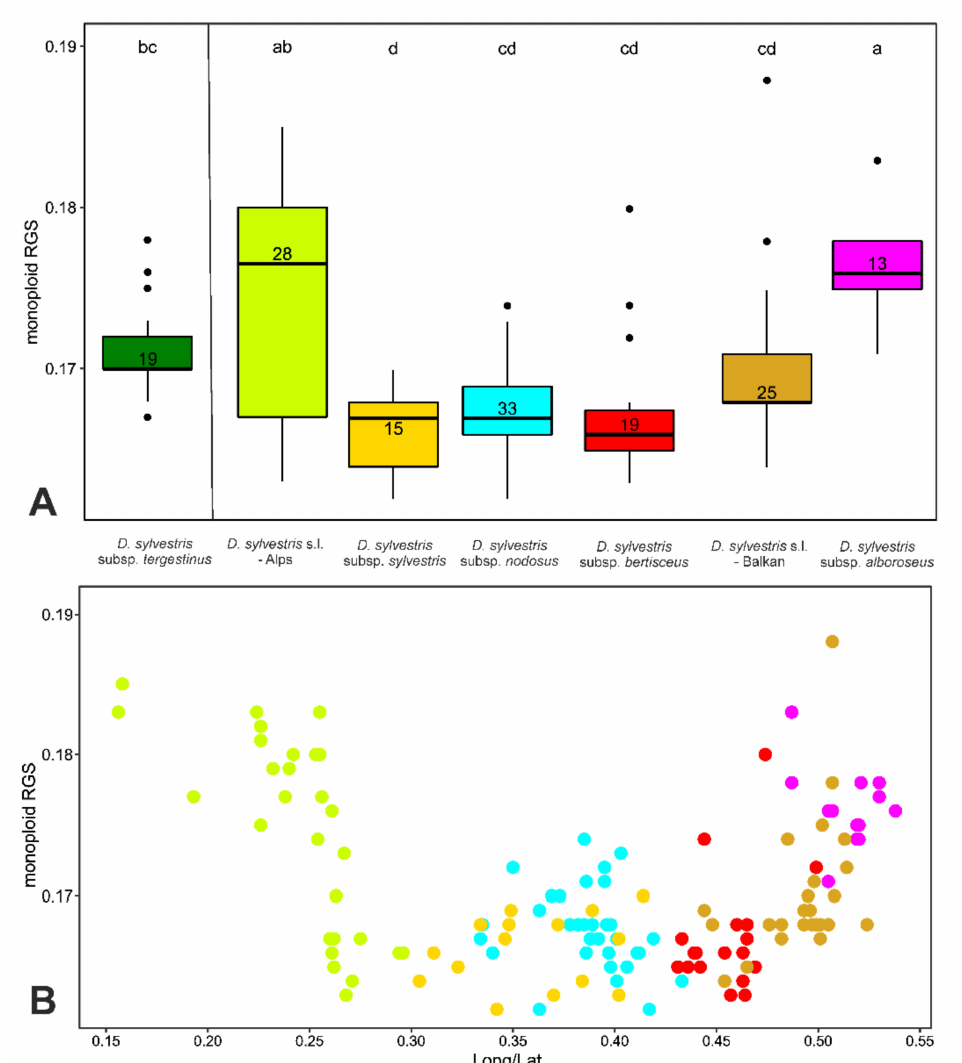
Figure 6. Monoploid RGS variation based on population means of 152 DNA-diploid populations of Dianthus sylvestris s.l. Color coding for taxa corresponds to Figure 2. ( A ) Boxes in the boxplot and ( B ) points in the scatterplot are arranged in geographical order from the north-west to the south-east. Being the most clearly distinguished subspecies, D. sylvestris subsp. tergestinus is singled out on the left of plot ( A ) and excluded from the plot ( B ). Boxes correspond to 25 and 75 percentiles, horizontal lines to medians, whiskers 5 to 95 percentiles, and circles to outliers. Means not significantly different at p < 0.01, according to the Tukey post-hoc test, are indicated by the same letter. Numbers adjacent to the median lines represent the sample